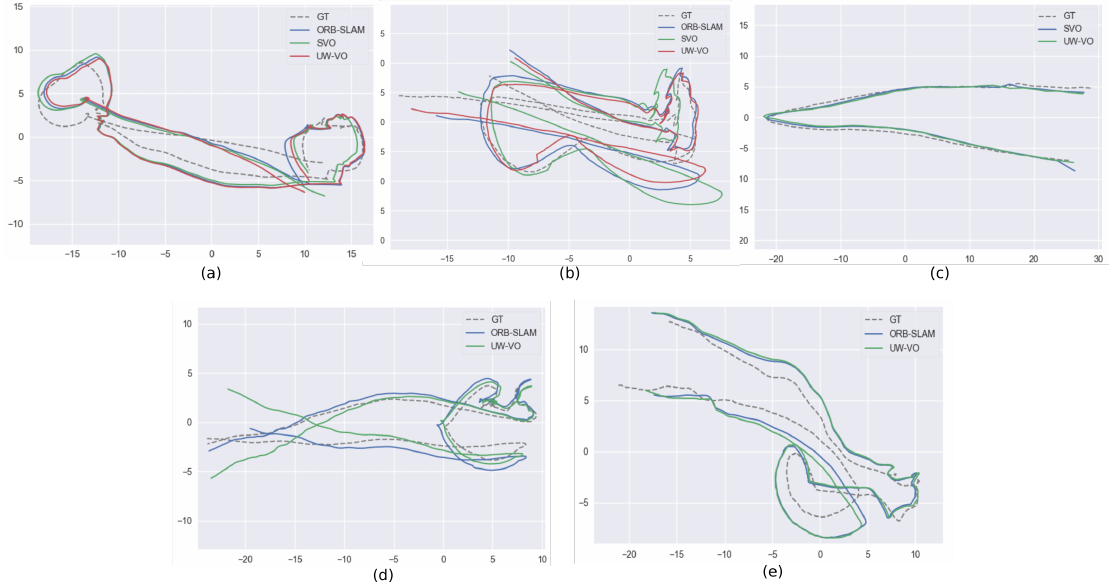
Figure 9. Trajectories of ORB-SLAM, SVO and UW-VO over the five underwater sequences. ( a ) Sequence 1, ( b ) Sequence 2, ( c ) Sequence 3, ( d ) Sequence 4, ( e ) Sequence 5. Ground-truths (GT) are extracted from Colmap